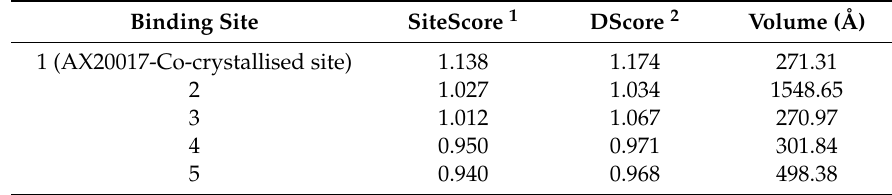
Table 1. Identified binding sites for Mt PknG using SiteMap.